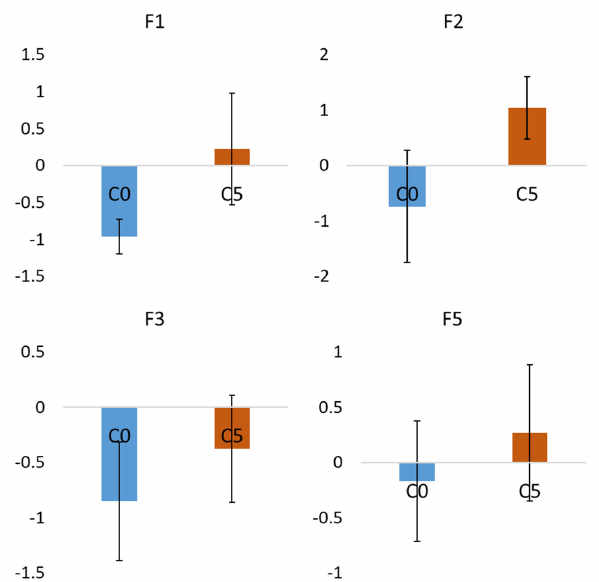
Figure 5. Mean factor scores which account for the differences between C0 and C5. Significant differences between C0 and C5 were found for F1, F2, F3, and F5. The differences between the means of independent groups were analyzed by Welch’s ANOVA with the Games–Howell method for post hoc pairwise tests and the significance level was set as 0.05. The mean CT density and J of the pattern clusters were calculated. The pattern clus- ters that were highly positively associated with each factor were denoted as f0−f5. The pattern clusters that were highly negatively associated with F2 and F3 were denoted as f2n and f3n, respectively (i.e., pattern clusters associated with the negative portion of the bi-polar factors). We found that f1 and f2 had a relatively low CT density and J (f1: CT density = 0.097, J = 0.504; f2: CT density = 0.125, J = 0.588), f3 had a high density but low J (CT density = 0.156, J = 0.442), and f5 had a low CT density but high J (CT density = 0.088, J = 0.769). On the other hand, f2n had both the highest CT density and J (CT density = 0.267, J = 1.470), and f3n had a relatively high CT density and J (CT density = 0.159, J = 0.690, Figure 6b). Examples of f1, f2(n), f3(n), and f5 are shown in Figure 6a.